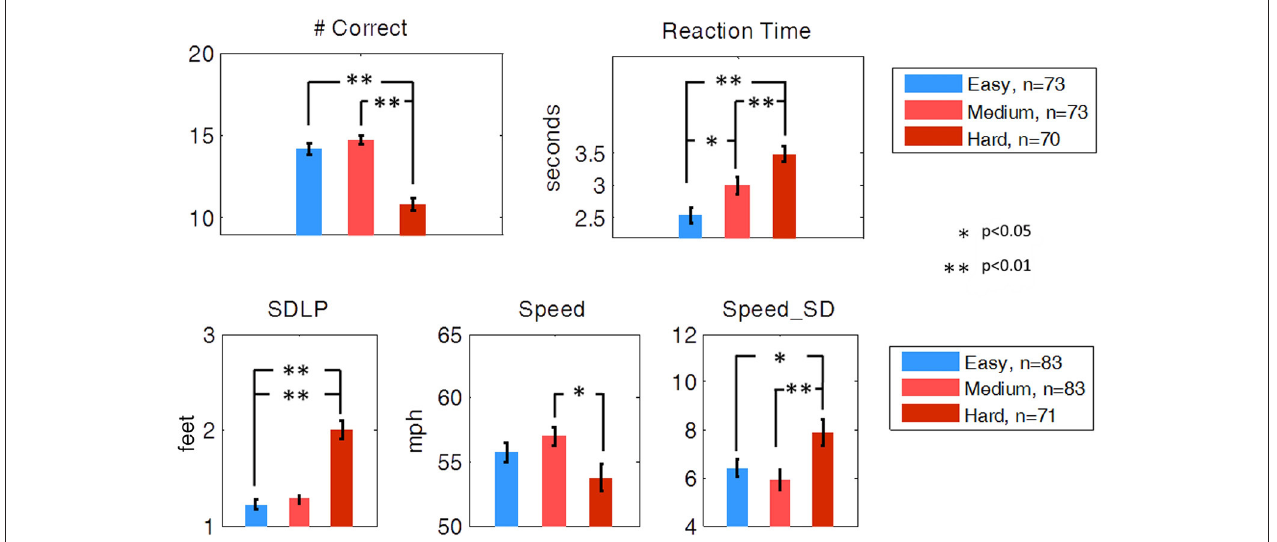
FIGURE 5 | Secondary task performance and driving performance during the SuRT Easy, Medium, and Hard task. Participants performed worse, as indicated by all metrics except average speed, on the most difficult SuRT task.